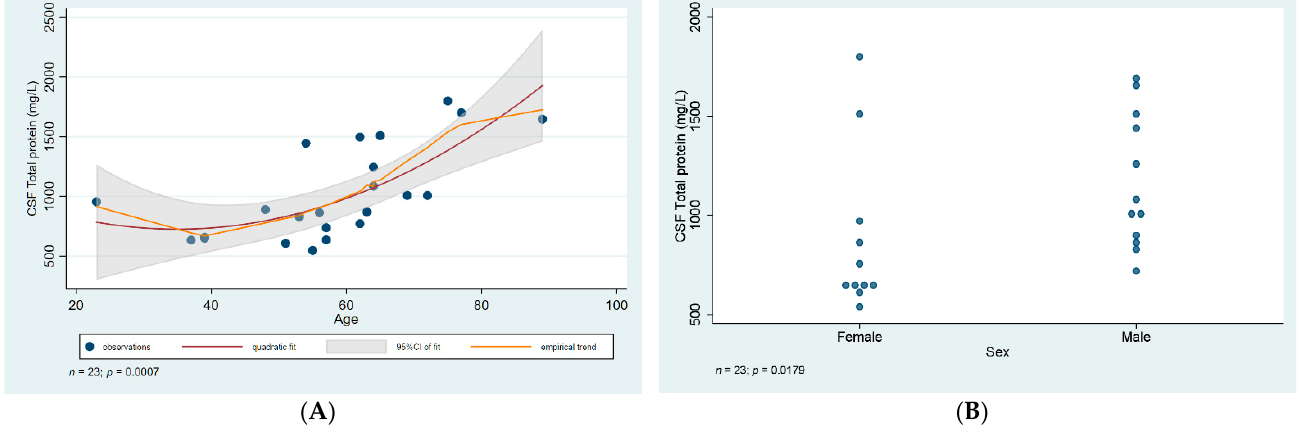
Figure 3. Statistical analysis of CSF total protein level. ( A ) Scatter plot of CSF total protein level against age with linear regression fit and empirical trend superimposed. ( B ) Categorical scatter plot of CSF total protein level by sex. CSF—cerebrospinal fluid; CI—confidence interval. Age ‐ adjusted comparison revealed that this was fully due to confounding, explained by male patients being significantly older on average (64.6 years versus 50.5 in females; p = 0.02).